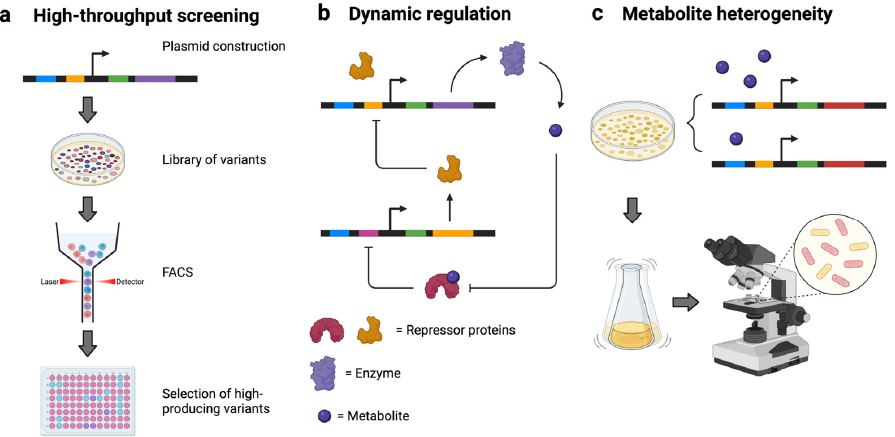
Figure 3. Applications of TF-based metabolite biosensors. ( a ) High-throughput screening of genetic libraries to select active enzymes or high-producing strains; ( b ) metabolite sensor-enabled dynamic regulation of metabolic pathways (example of a negative feedback loop to control metabolite production); ( c ) studying metabolite heterogeneity within an isogenic cell population using metabolite biosensors.